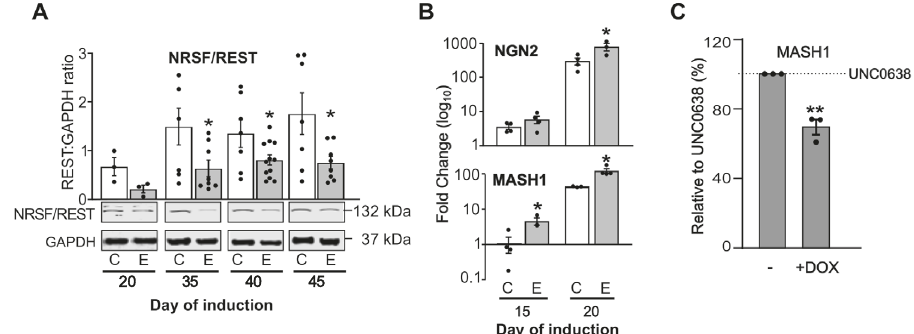
Fig. 3 Reduced EHMT1 activity elevates REST-target gene expression during neuronal development. A Western blot analysis of NRSF/REST protein expression in hiPSCs-derived neurons at Day 20 (NPC stage) and maturing neurons at Days 35, 40 and 45 of differentiation. NRSF/REST protein was decreased in EHMT1 − / + -derived neurons. Quanti fi cation of Western blot analysis was performed by normalization to GAPDH. A representative image from at least three independent experiments is shown, with all vales shown on the graph above. B Time-course qRT-PCR analysis at Days 15 and 20 of differentiation to examine changes in the expression of lineage-speci fi c REST-target genes NGN2 and MASH1 in EHMT1 − / + -derived neurons compared to their isogenic control hiPSCs. Relative changes is expressed as mean fold change over pluripotent cells, n ≥ 3 independent experiments. C Relative mRNA abundance measured by qRT-PCR of MASH1 in wild type hiPSCs treated with UNC0638. Induction of REST Δ UTR with doxycycline (DOX) suppresses the UNC0638-induced MASH1gene expression. Data were presented as Mean±SEM and analysed by student ’ s t-test or One-way ANOVA with post hoc comparisons using Dunnett ’ s multiple comparisons test comparing to control